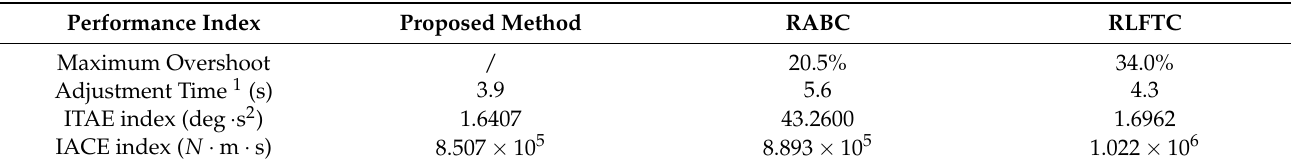
Table 1. Performance indexes of the α -channel.